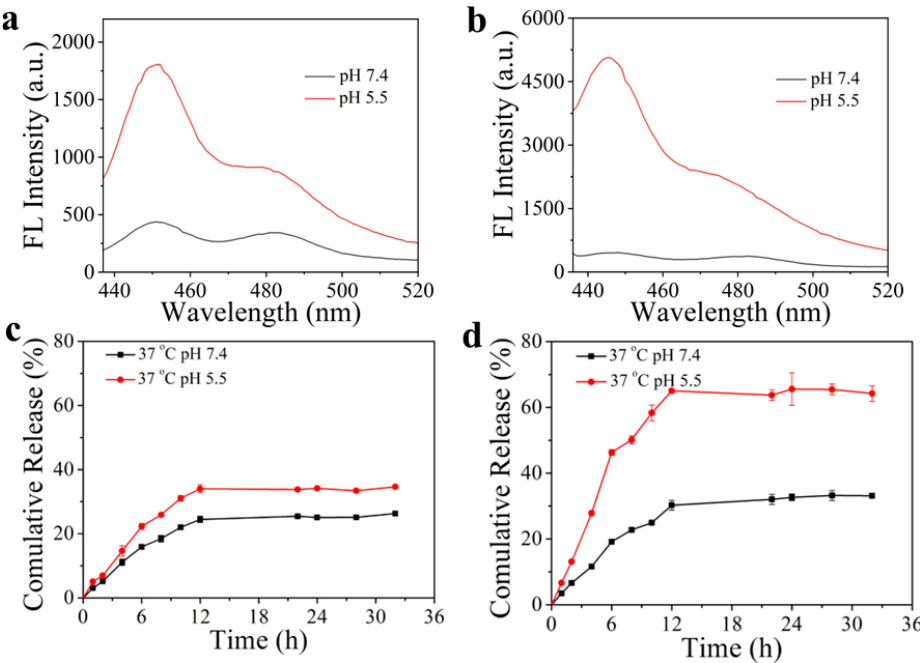
Figure 4 . The fluorescence recovery effect of ( a ) PFE ‐ DOX ‐ 1 and ( b ) PFE ‐ DOX ‐ 2 after the reaction Figure 4. The fluorescence recovery effect of ( a ) PFE-DOX-1 and ( b ) PFE-DOX-2 after the reaction in in PBS buffer with different pH values. DOX release curves of ( c ) PFE ‐ DOX ‐ 1 and ( d ) PFE ‐ DOX ‐ 2 PBS buffer with different pH values. DOX release curves of ( c ) PFE-DOX-1 and ( d ) PFE-DOX-2 in in PBS buffer with different pH values. PBS buffer with different pH